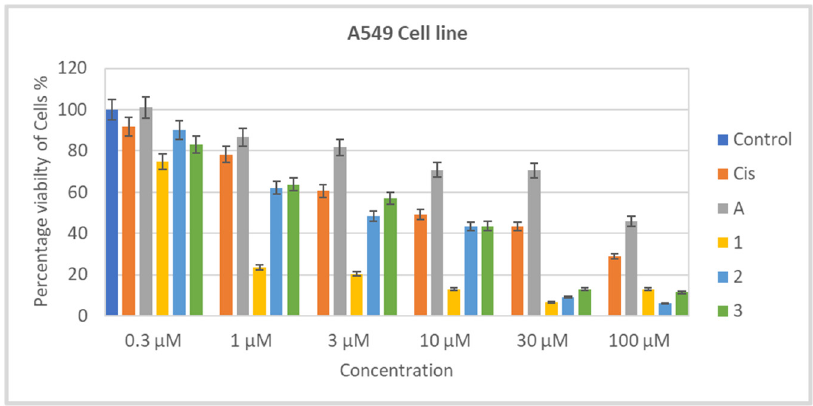
Figure 2. Effect of the concentration of complexes A, 1 – 3 and cisplatin on the viability of A549 cells.